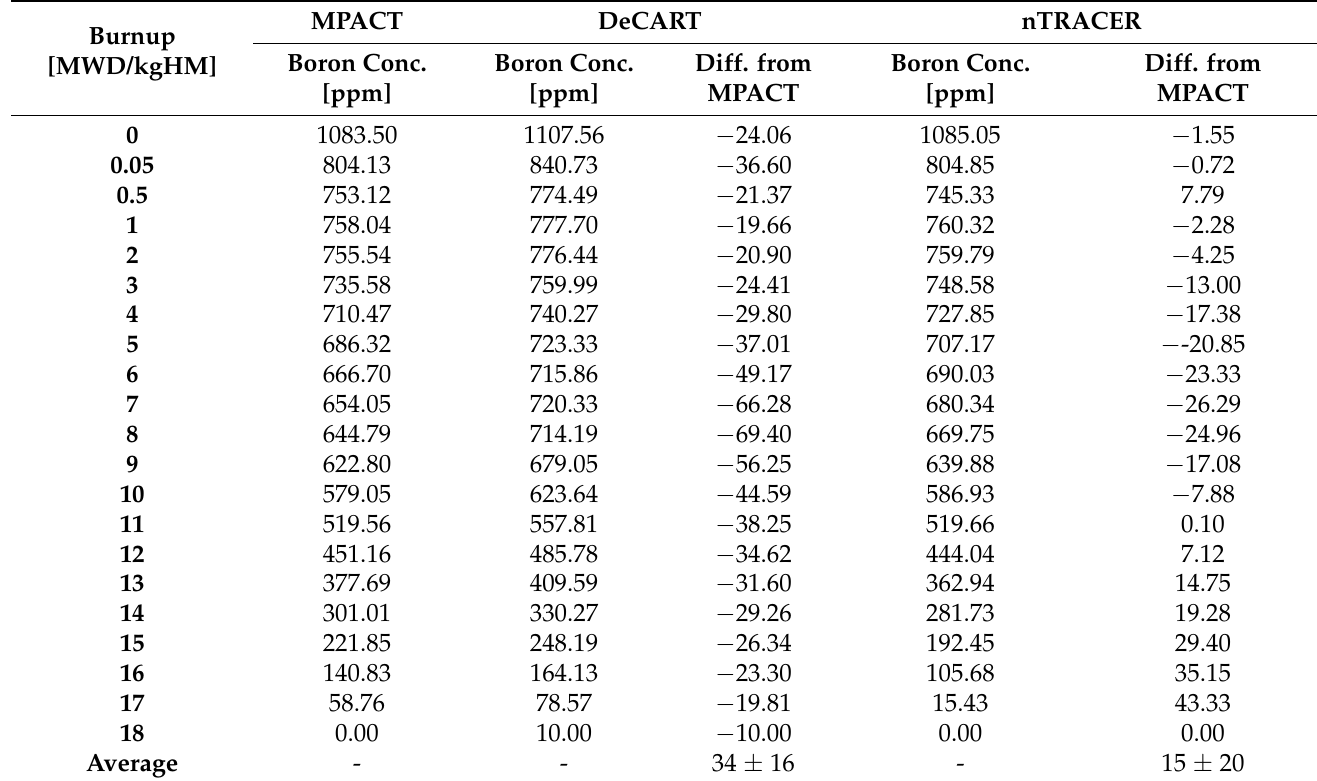
Table 9. MPACT, DeCART, and nTRACER boron concentrations for different